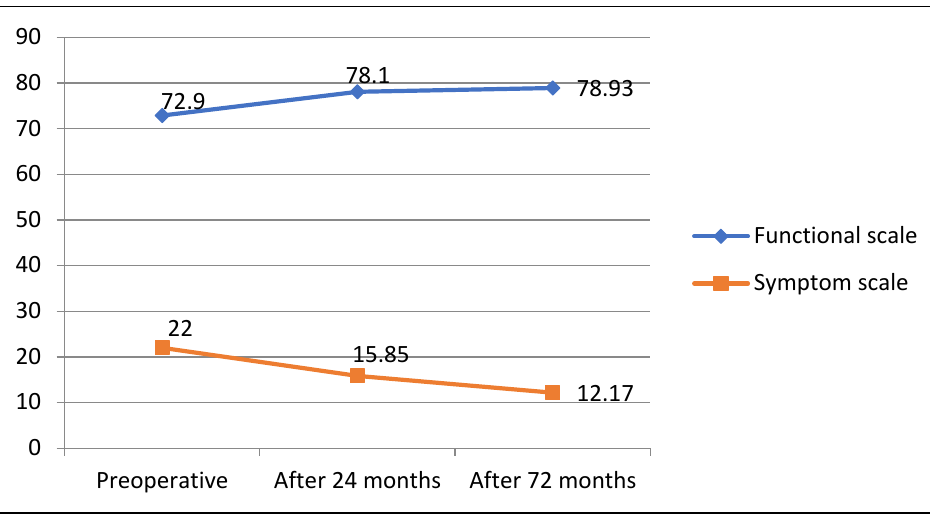
Figure 6. Stage and general health status.